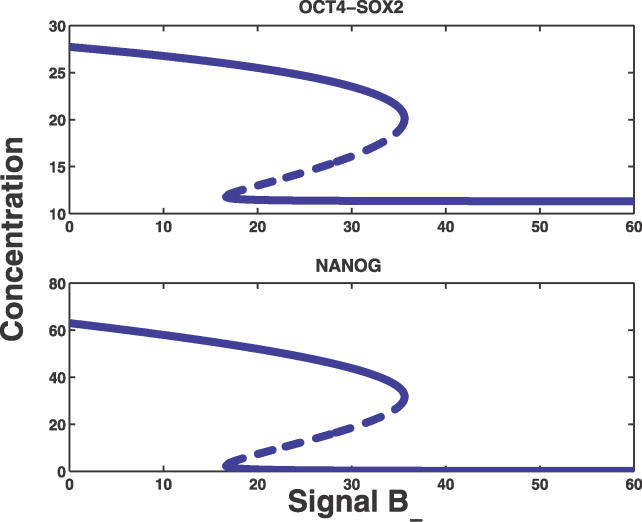
Steady State Behavior of OCT4–SOX2 and NANOG Concentration Levels as a Function of the Signal B
−
The system is a bistable switch with respect to the B
− concentration. As the threshold is crossed (B ≈ 36, arbitrary units), NANOG turns off, and OCT4 and SOX2 are reduced to lower levels. Since the signal is still present (A
+ = 100), the OCT4 and SOX2 levels do not decline to very low levels.